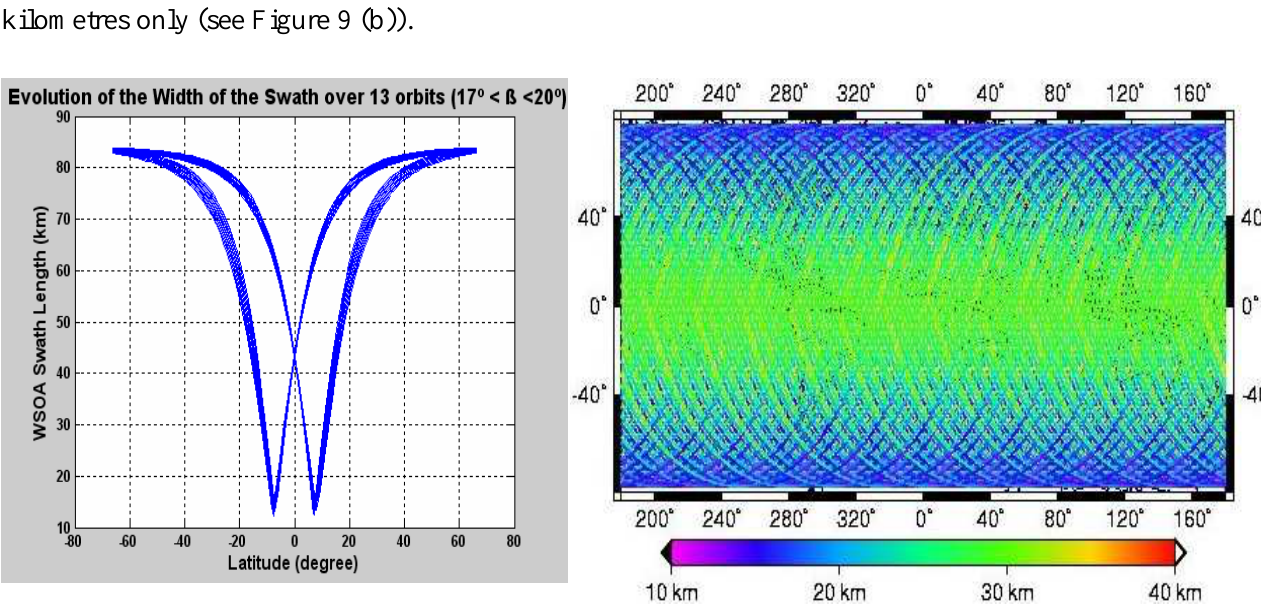
Figure 9. (a) Evolution of the Swath over 13 orbits at the beginning of yaw steering (b) Width of the swath over 10 days in the worst case (-75º< β